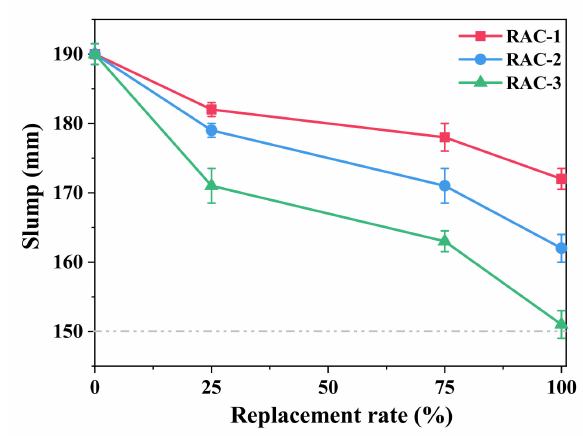
Figure 3. Workability of RRAC with different replacement rates.